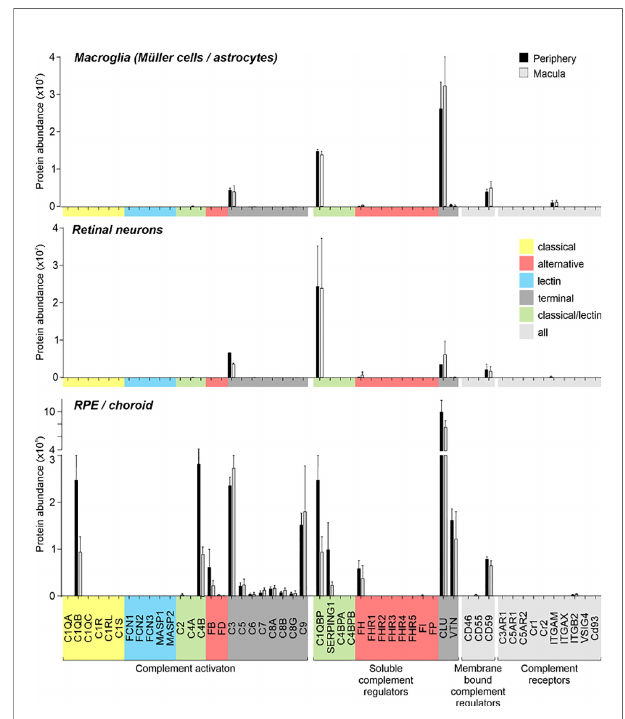
FIGURE 3 | Complement proteome of macroglia (Müller cell, astrocytes), retinal neurons and RPE/choroid in the macular and peripheral human eye. Müller cells and retinal neurons were puri fi ed from peripheral and macular retinal tissue punches (6 mm in diameter) from 5 donor retinae ( Table S1 ) by magnetic- activated cell sorting (MACS) and were submitted to quantitative LC MS/MS mass spectrometry. Contamination with astrocytes is likely, because no surface marker yet separates them clearly from Müller cells. Müller cells de fi nitely outnumber astrocytes. Macroglia and neurons were depleted from ITGAM (alias CD11B)-positive microglia/macrophages and CD31-positive vascular cells. RPE/ choroid was collected after the removal of retinal tissue and comprised a mixture of RPE and choroidal cell types including pericytes, endothelial cells, fi broblast and immune cells. Given the intense perfusion of choroidal tissues, these samples do not allow unequivocal discrimination of the source especially of soluble complement components as they could be expressed by local cell types or by liver cells and enter the choroid via the